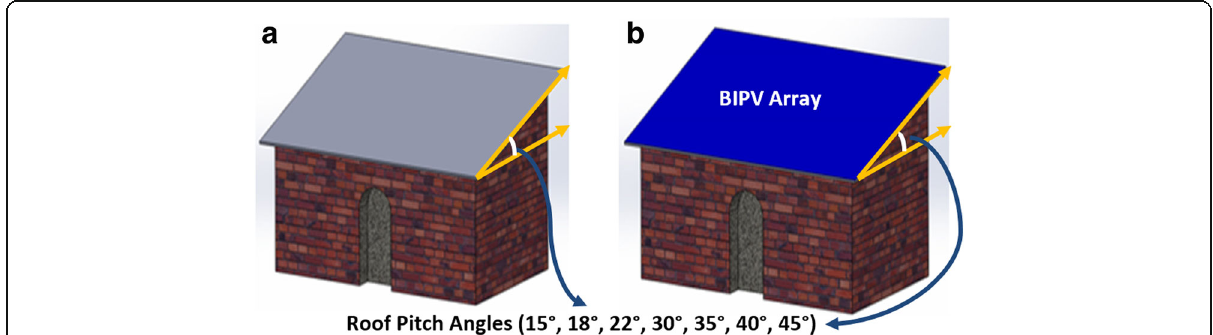
Fig. 3 a South-facing single-sloped roof house. b South-facing single-sloped roof house with